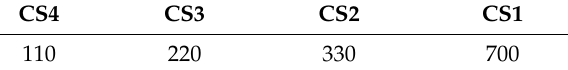
Figure 8. Experimental layout, with an inlet honeycomb to calm the inflow and an outlet flip gate to regulate the tailwater at a given flow rate. Near the left bank at each of CS1–CS6, a point gauge monitors the water level, a velocimeter records flow velocities, a 90° sharp-crested weir measures flow rates, and a PIV system, mounted under the roof, captures the surface flow velocity across the model. Table 2. Location of cross-sections CS1–CS6, measured along the river centerline.